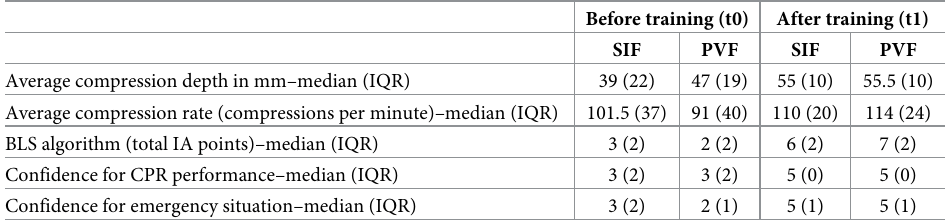
Table 1. Performance data and self-reported confidence ratings before and after the training.